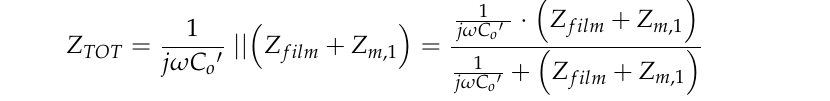
( b ) Figure 6. Simulated responses of a functionalized QCM as a function of the RH level (hence on the film density), with initial film 1000 kg/m 3 and considering three different initial film thicknesses (h 01 Medium RH High RH Low RH Medium RH Growingh and constant attenuation High RH growingh and attenuation Low RH Constant h and attenuation